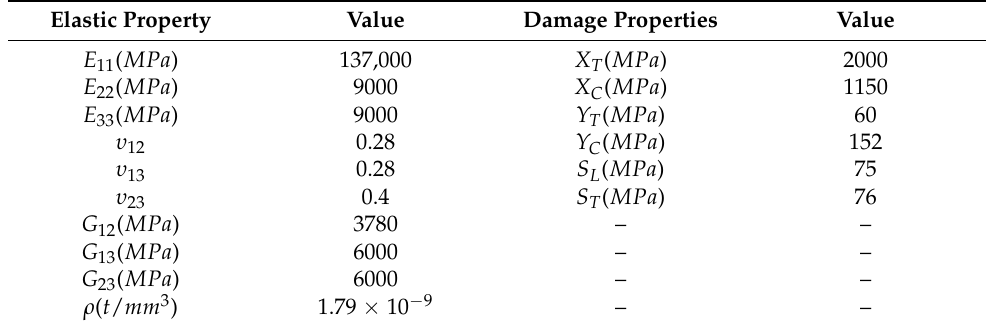
Table 4. Mechanical properties of the CFRP plate [39].